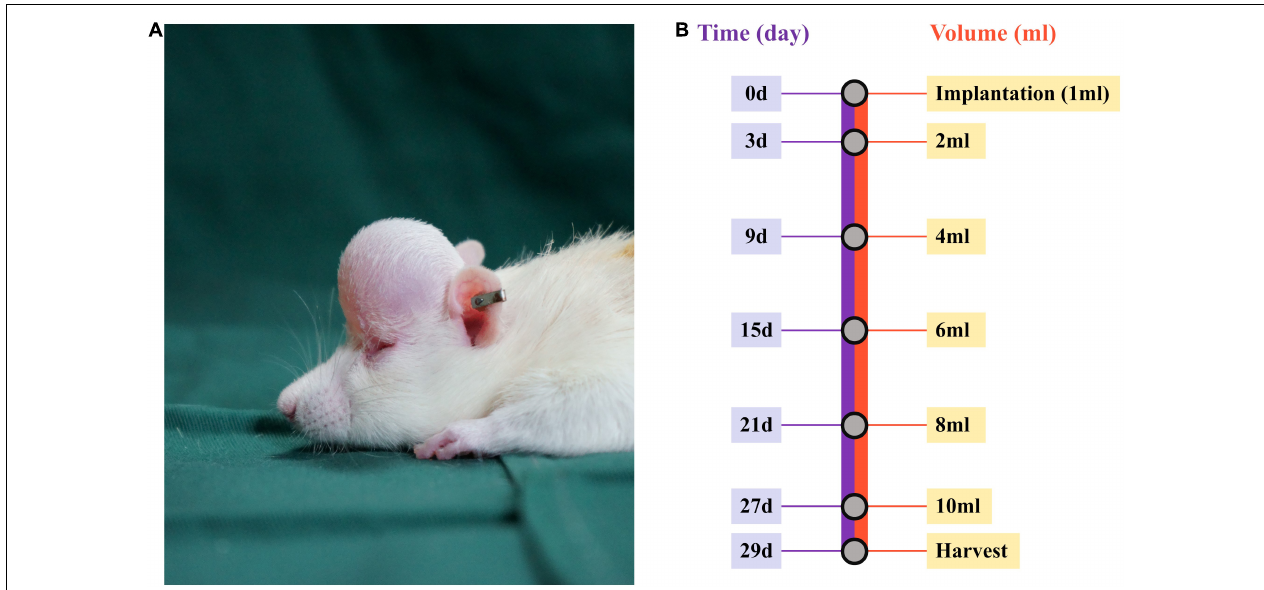
FIGURE 1 | Establishment of the mechanical stretch model and experimental design. (A) A round silicone expander was implanted under the rat scalp, and (B) 1 mL of normal saline was injected into the expander every other day up to a final injection on day 27. At 48 h after the final injection, the mechanically stretched skin was harvested for